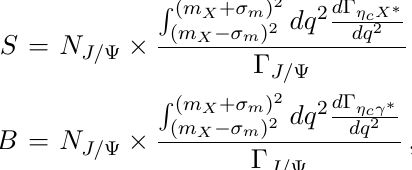
Figure 1 . The e + e − invariant mass distributions of signal J/ Ψ → η c X ∗ → η c e + e − (red) and background J/ Ψ → η ∗ → η + e − (black), where q 2 ≡ m 2 c γ c e 17 MeV, ε = 3 . 7 × 10 − 3 , and ε = 10 − 3 c e